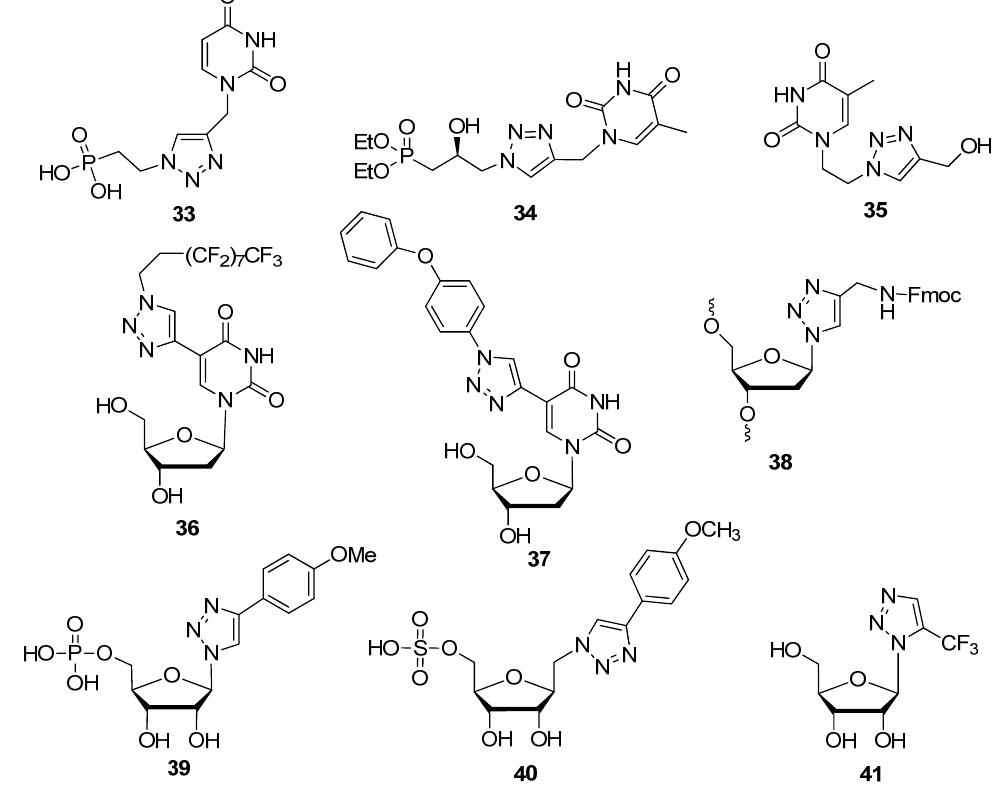
Figure 5. Nucleic acid-based compounds displaying anticancer or antiviral